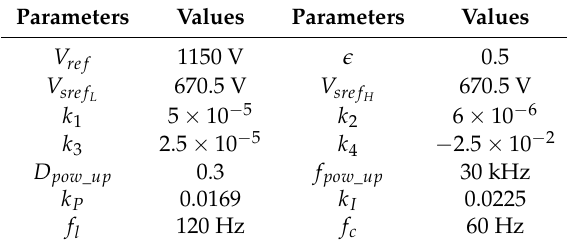
Table 4. Control parameters of the